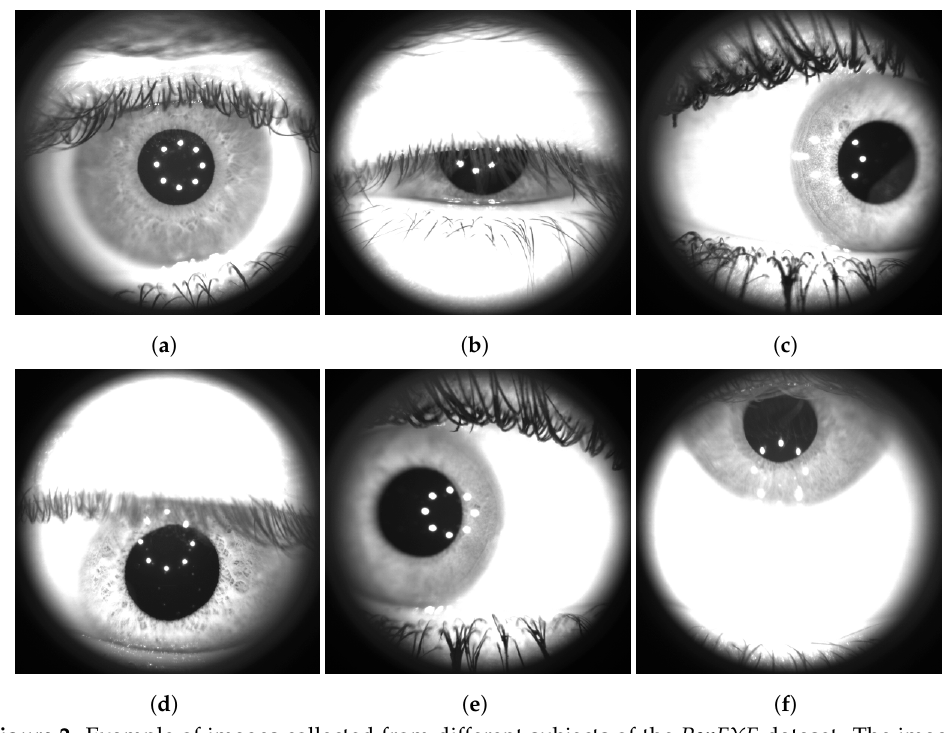
Figure 2. Example of images collected from different subjects of the PopEYE dataset. The images have been labeled in six different categories: ( a ) correct, ( b ) closed, ( c ) right, ( d ) down, ( e ) left, and ( f ) up. As shown in the images, the pupil, the iris, the eyelashes and, in certain cases, the eyelid is visible. Visible white spots disposed in a circle near the pupil are reflections produced by the 8 IR LEDs used to illuminate the eye.